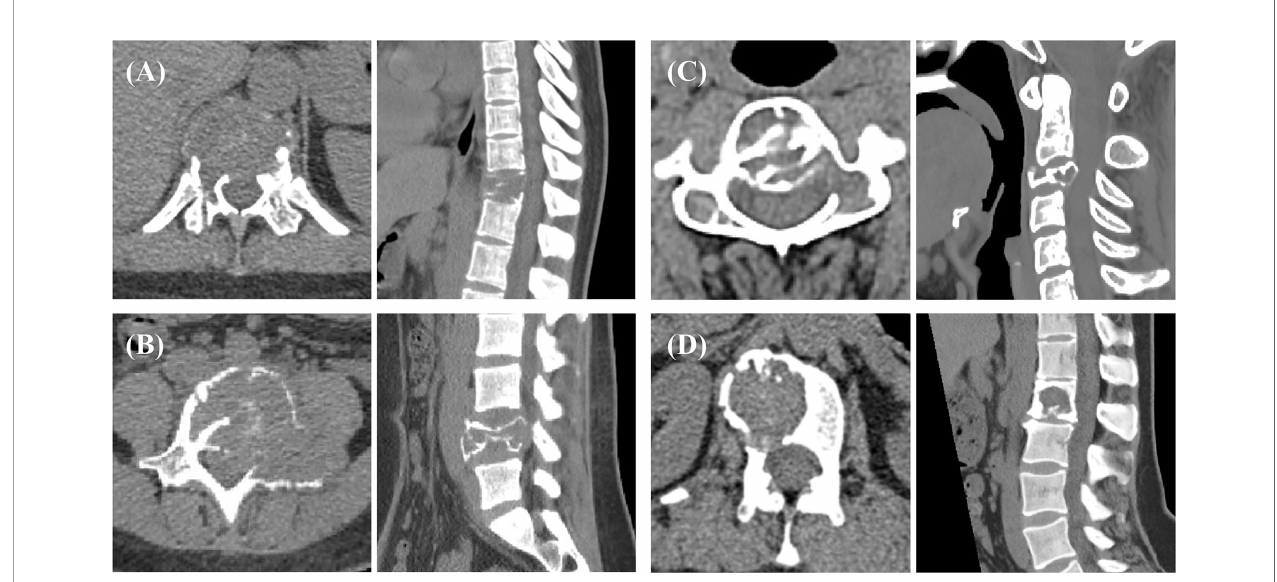
FIGURE 2 | Spinal GCTB case examples from 4 patients. The boundary of the lesion can be clearly observed on the transverse images, which are used for tumor ROI drawing. The sagittal images show vertebral compression, spinal canal compression, and spinal stability, which are used to determine additional imaging features. The biomarker results of these patients: (A) mutant p53 and high VEGF; (B) mutant p53 and low VEGF; (C) wild-type p53 and high VEGF; and (D) wild- type p53 and low VEGF. The SINS of these 4 patients were 18, 11, 11, and